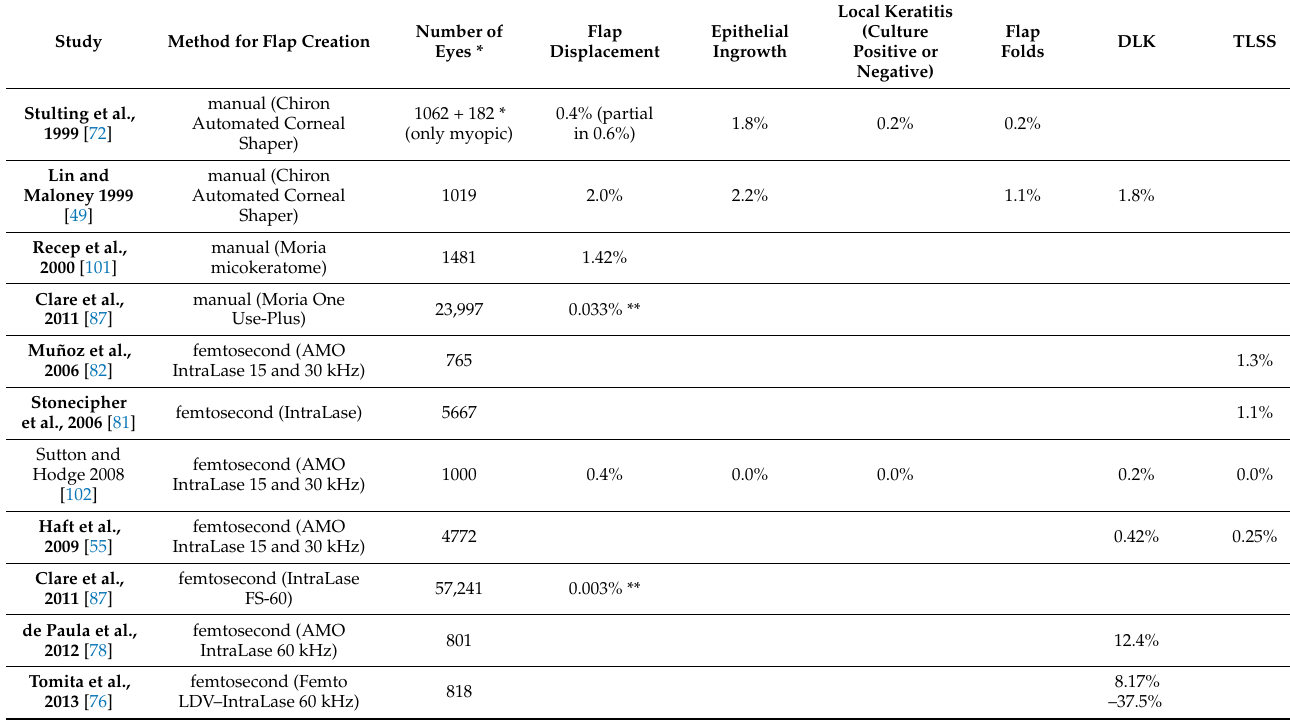
Table 2. Large clinical studies that analyze the rate of postoperative complications in manual and femtosecond laser flap creation. The total risk of complications is stated only if calculated within the